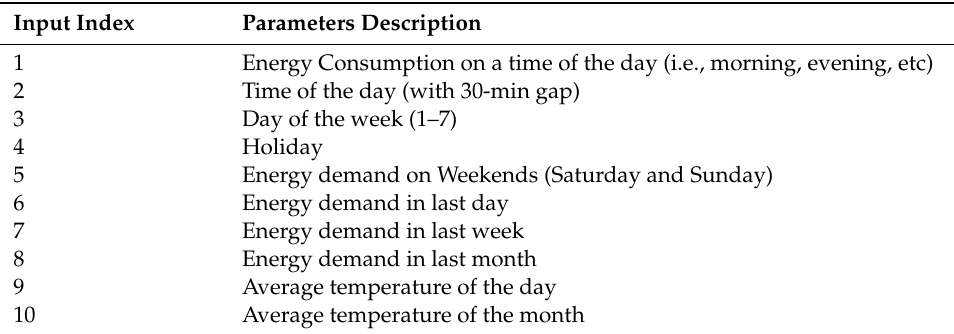
Table 3. Input parameters to the BLSTM